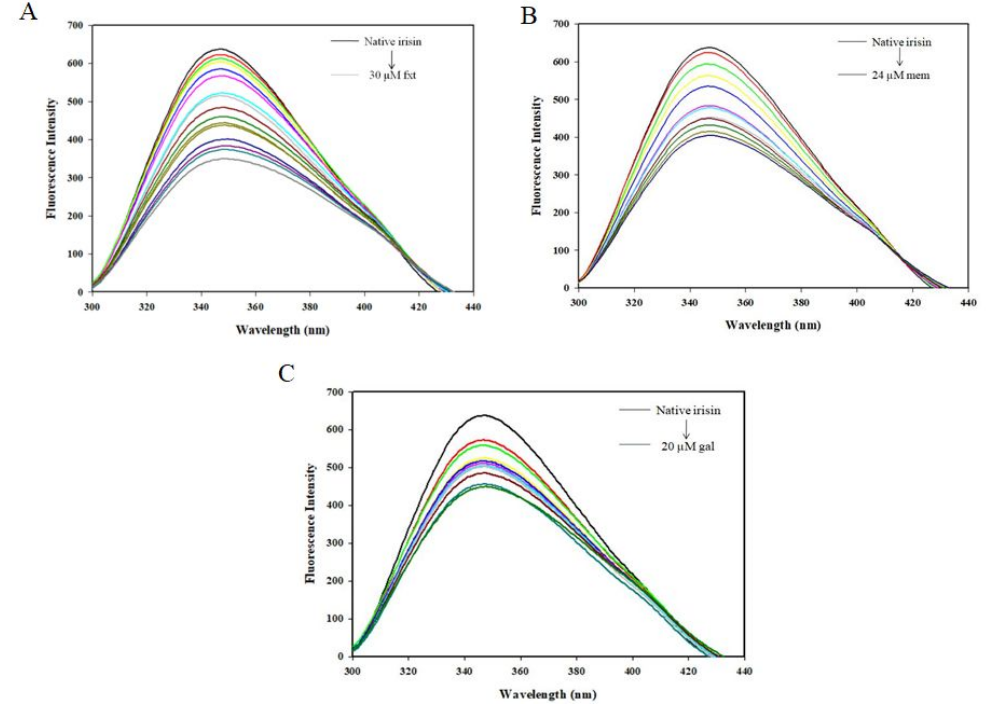
Figure 2. The fluorescence spectra of irisin in the presence of ( A ) Fluoxetine (0–30 µM), ( B ) Memantine (0–24 µM), and ( C ) Galantamine (0–20 µM).